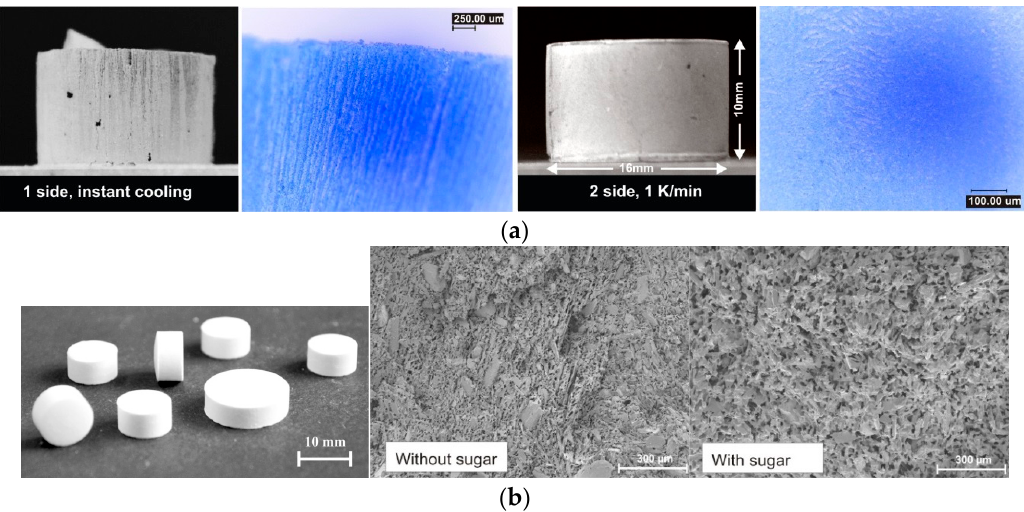
Figure 2. Examples of micropore structures of freeze-casted tablets: ( a ) needle-like structure (left) and planar lamella structure of freeze casted cocoa tablets [13]; ( b ) microspore structures of freeze-casted paracetamol tablets, with and without additive ( i.e. , sugar-sucrose) [13].